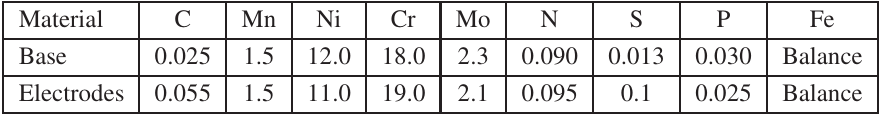
Table 1. Chemical Composition of 316L(N) Stainless Steel (wt.%).